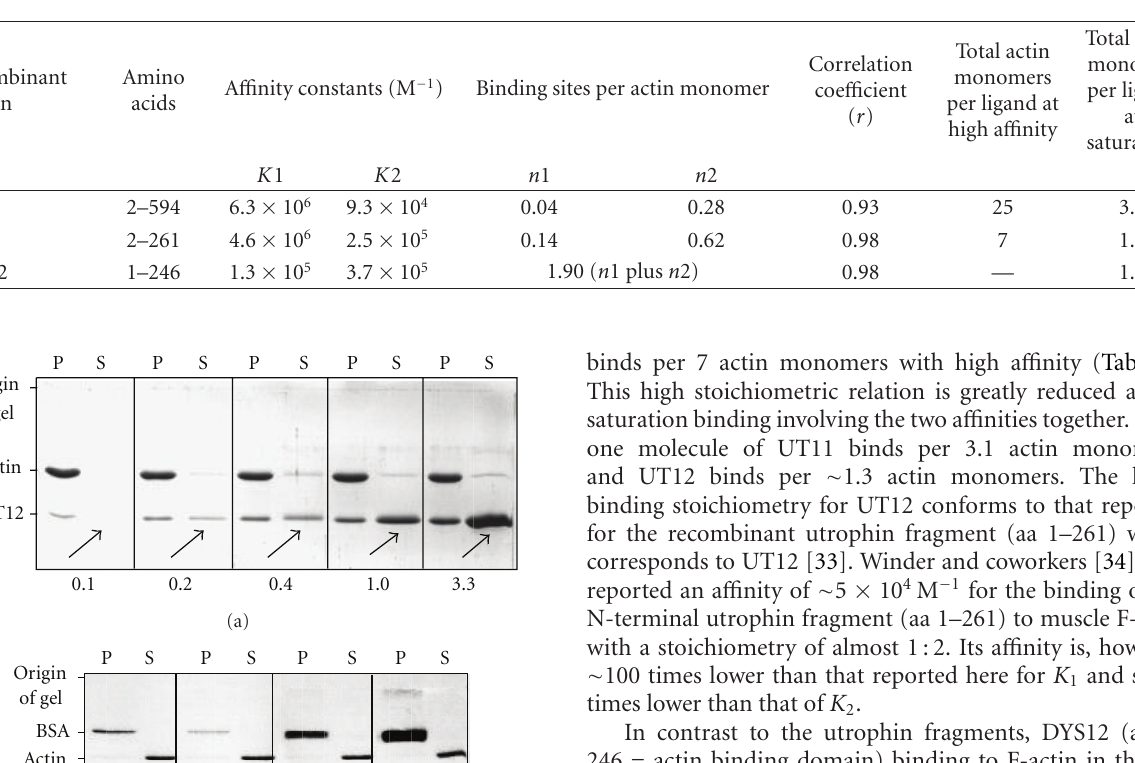
Table 3: Actin binding of recombinant protein fragments of utrophin and dystrophin. Parameters are derived from the binding data given in Figure 6.